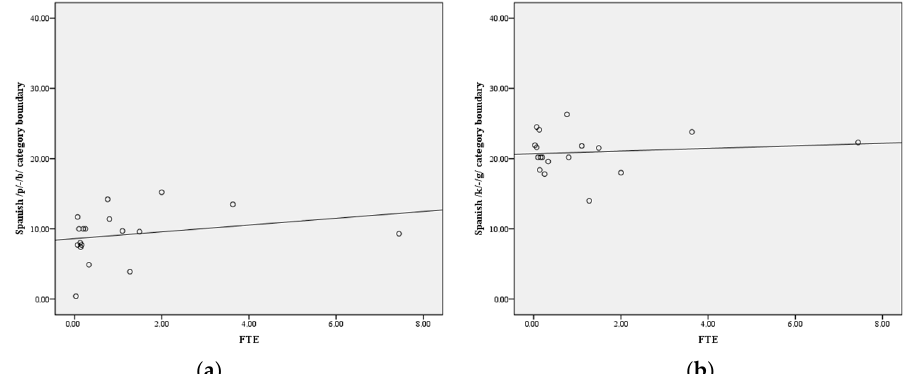
Figure 3. Scatterplots with fit lines for FTE ( x axis) and category boundary ( y axis) in English by the Spanish learners of English. ( a ) Category boundary for the /p/–/b/ contrast in English. ( b ) Category boundary for the /k/–/g/ contrast in English.